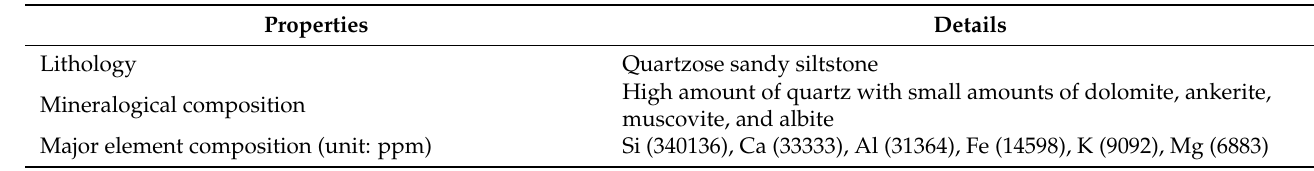
Figure 2. Downscaled cement–rock sample ( a ) and its CT image ( b ) and simplified binarized CT image ( c ). Table 1. Mineral and chemical composition of the Notikewin rock